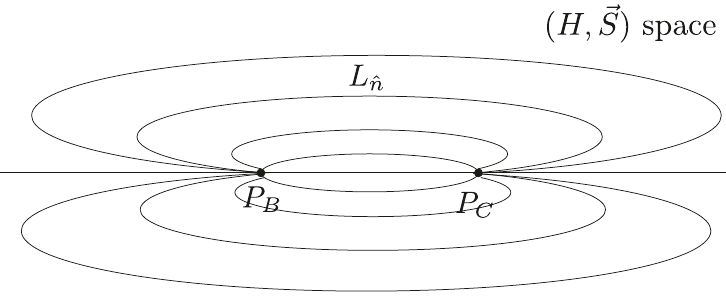
Figure 1 . We can foliate the D -dimensional con(cid:12)guration space by a set of L ^ n with ^ n 2 S D (cid:0) 1 starting with P B and ending at P C . Here we show the case of D = 2, where ^ n 2 S 1 is a point of the circle, namely speci(cid:12)es the direction in the neighborhood of the point P B